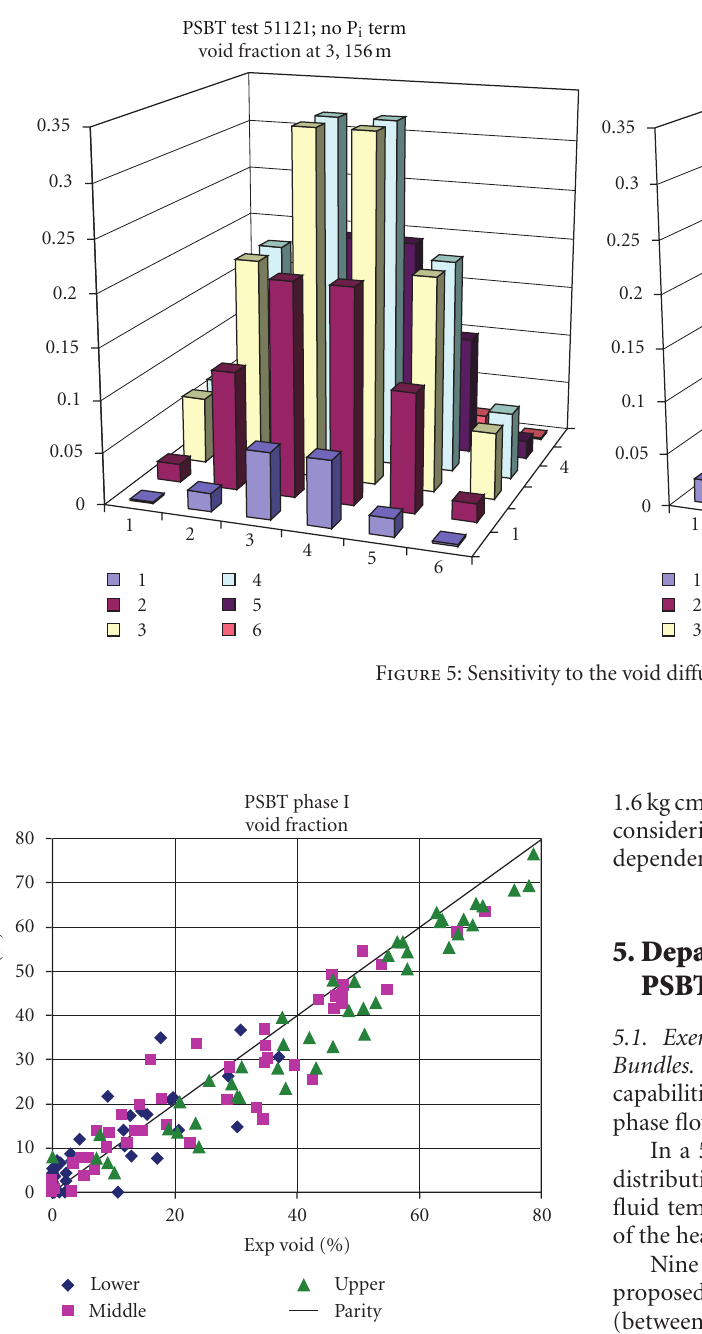
Figure 6: PSBT rod bundle test comparison of predicted and measured void fraction in central region at 3 di ff erent elevations along the heated length; lower: 2216 mm; medium: 2669mm; upper: 3177